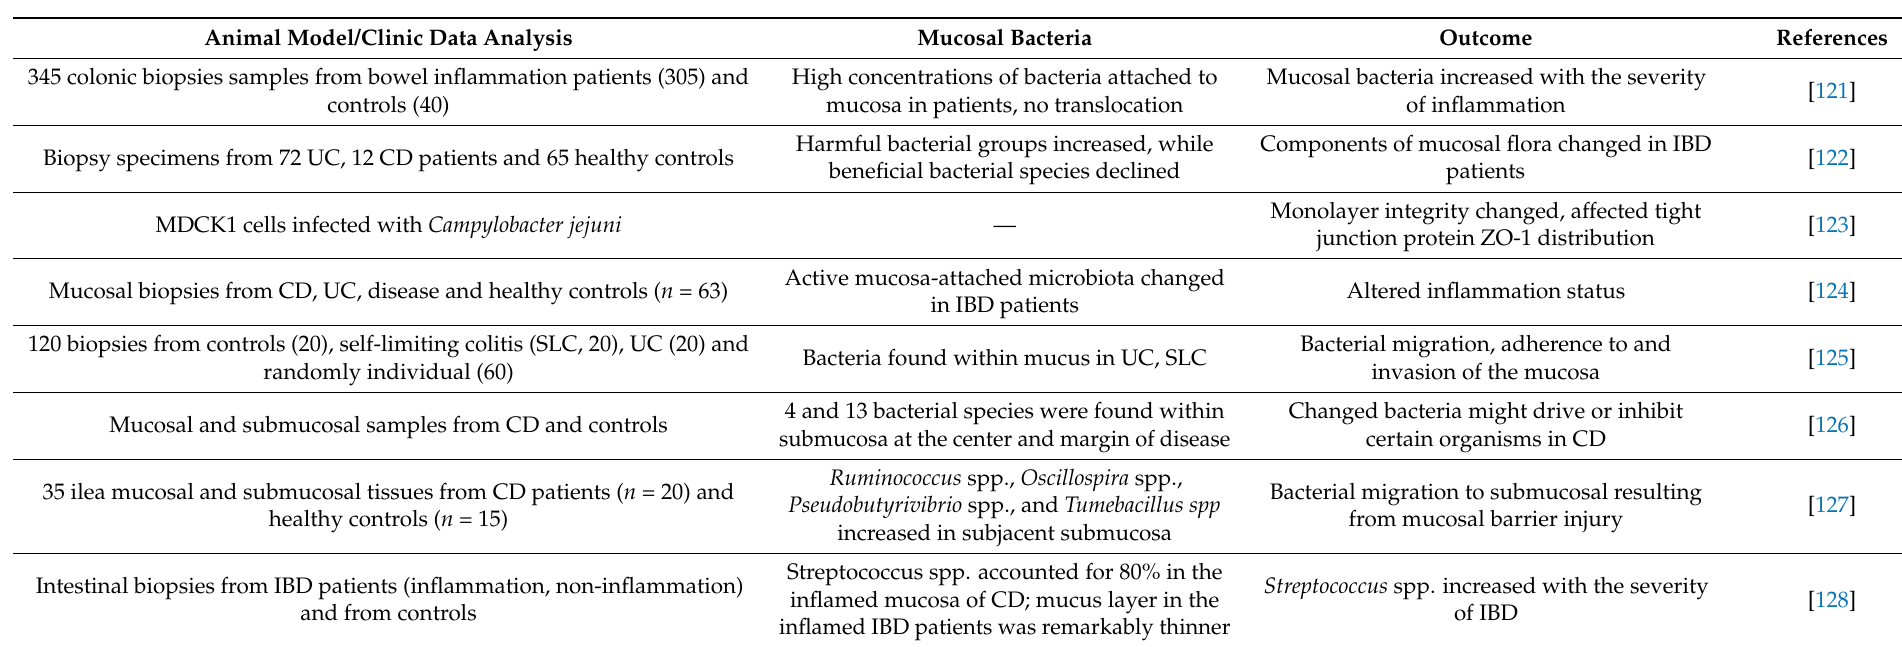
Table 3. Bacteria-mediated changes in the mucosal barrier in